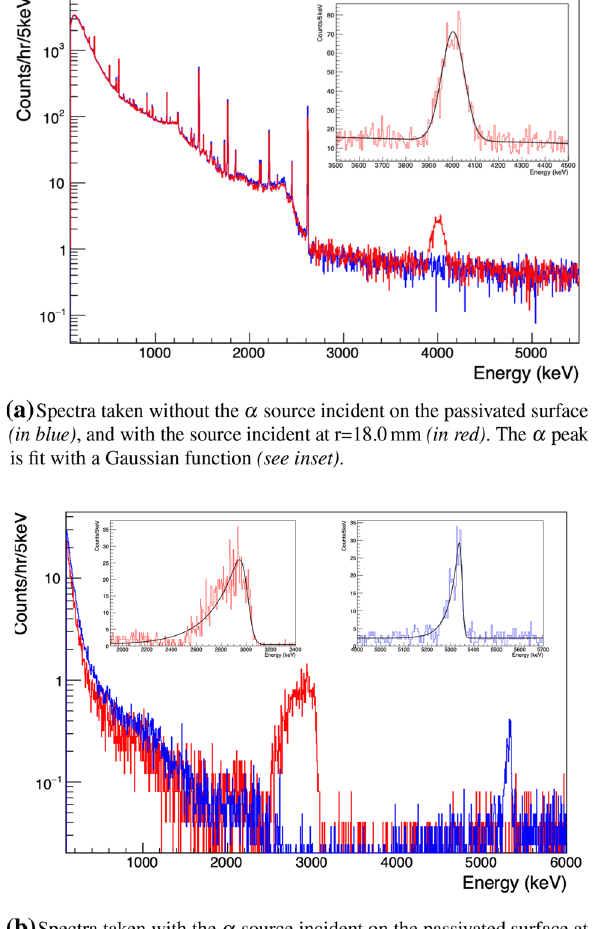
Fig. 15 TUBE energy spectra and fits to α peaks (in black), with (bot- tom) and without (top) an additional cut to select near-point-contact events